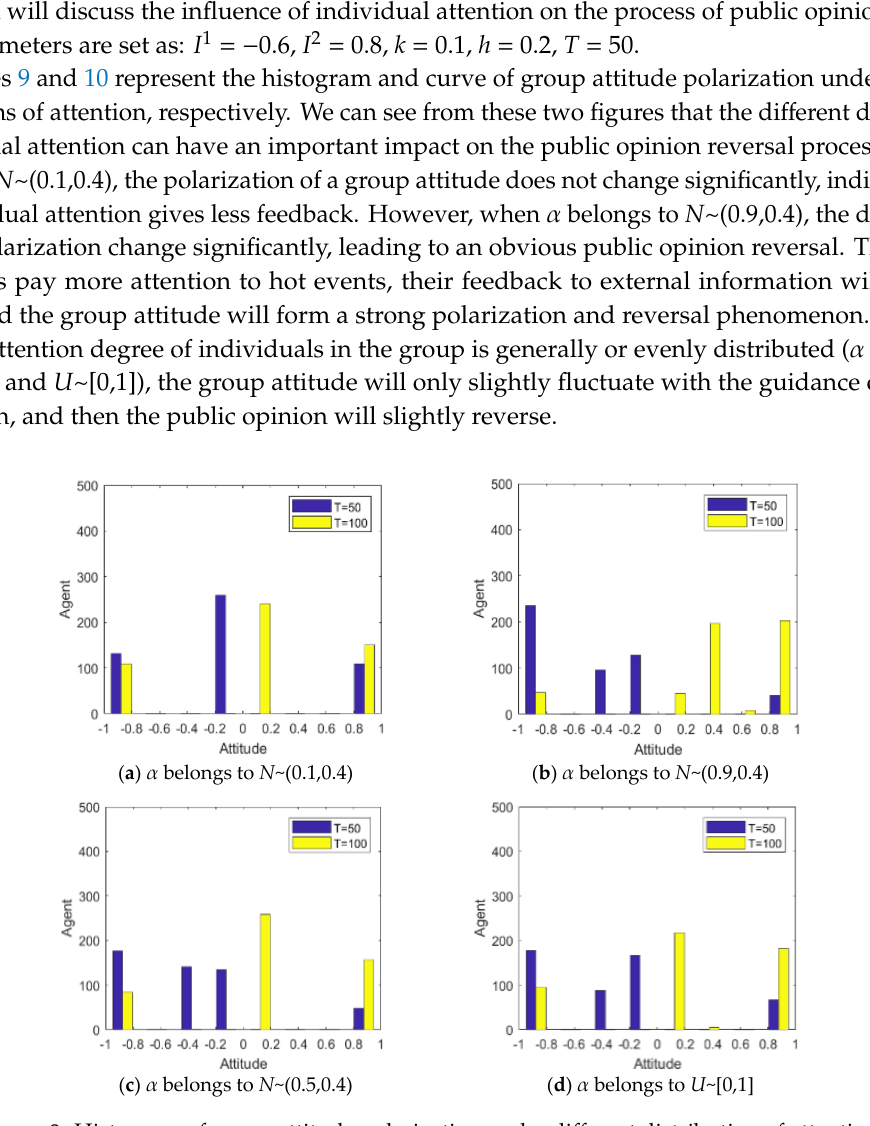
Figure 9. Histogram of group attitude polarization under different distribution of attention.( a ) α belongs to N ~(0.1,0.4); ( b ) α belongs to N ~(0.9,0.4); ( c ) α belongs to N ~(0.5,0.4); ( d ) α belongs to U ~[0,1].